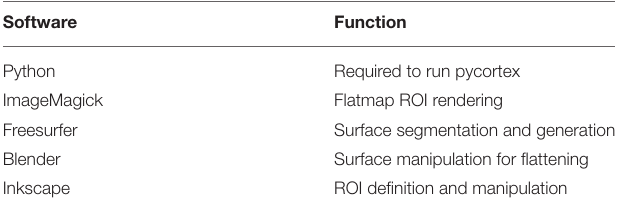
TABLE 1 | The following software is used in pycortex for either core or added